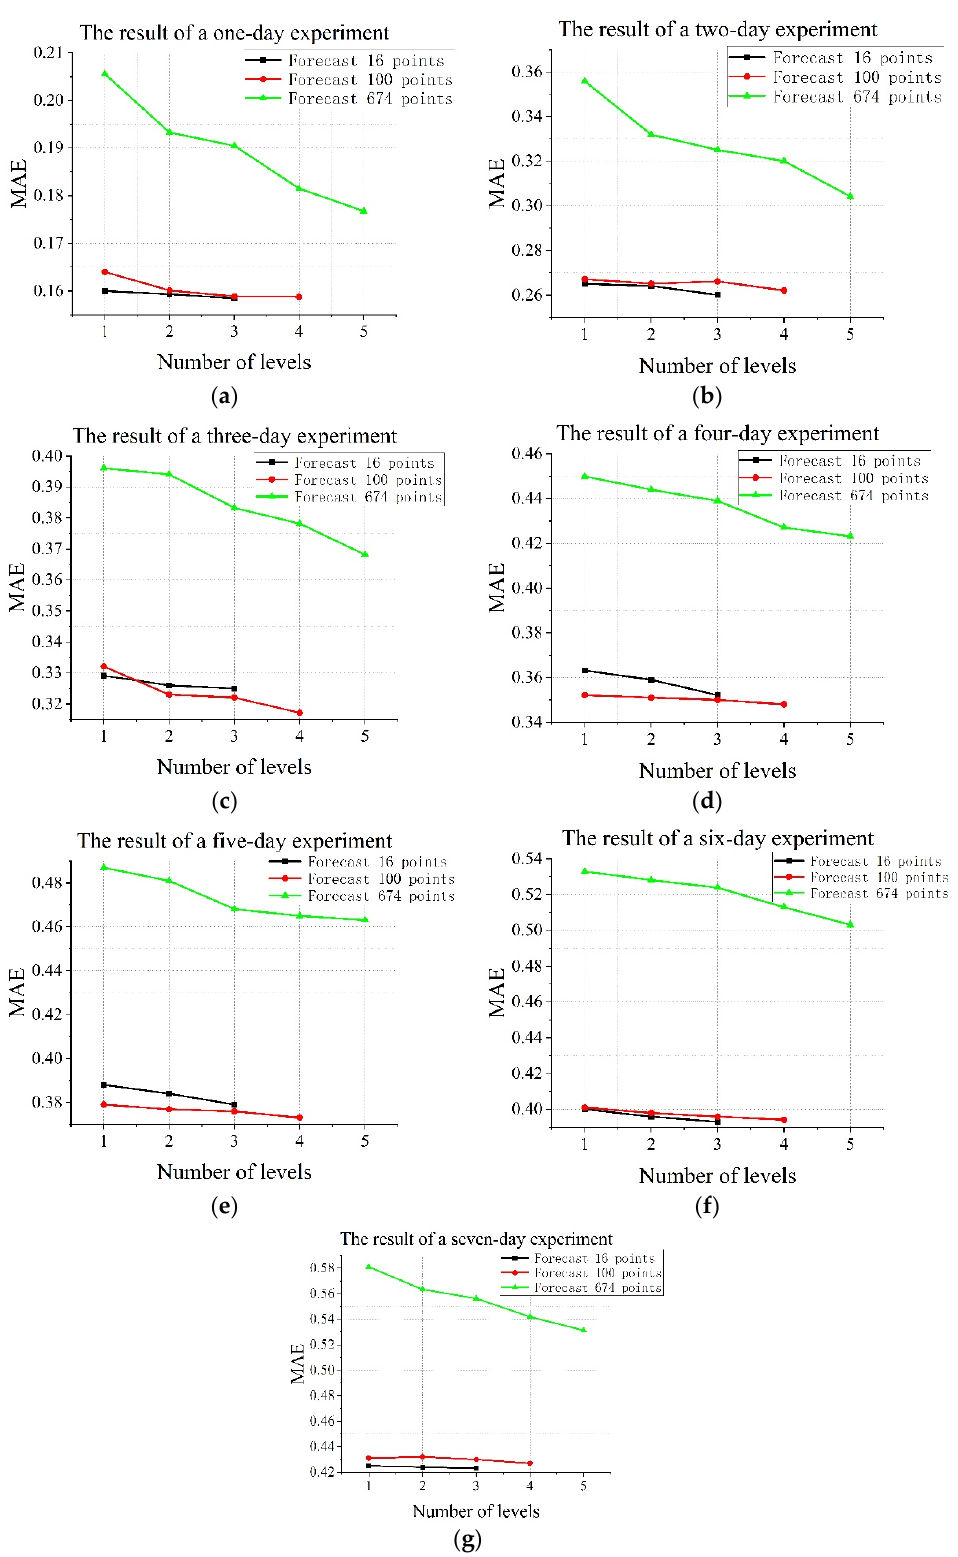
Figure 5. Results of CENS in the South China Sea for different levels. Comparing the experimental results of 16 prediction points in the Bohai Sea and the South China Sea, we can see that when the prediction area is small, the MAE and RMSE of CENS will generally decrease with the increase in the number of levels, but the improvement is not